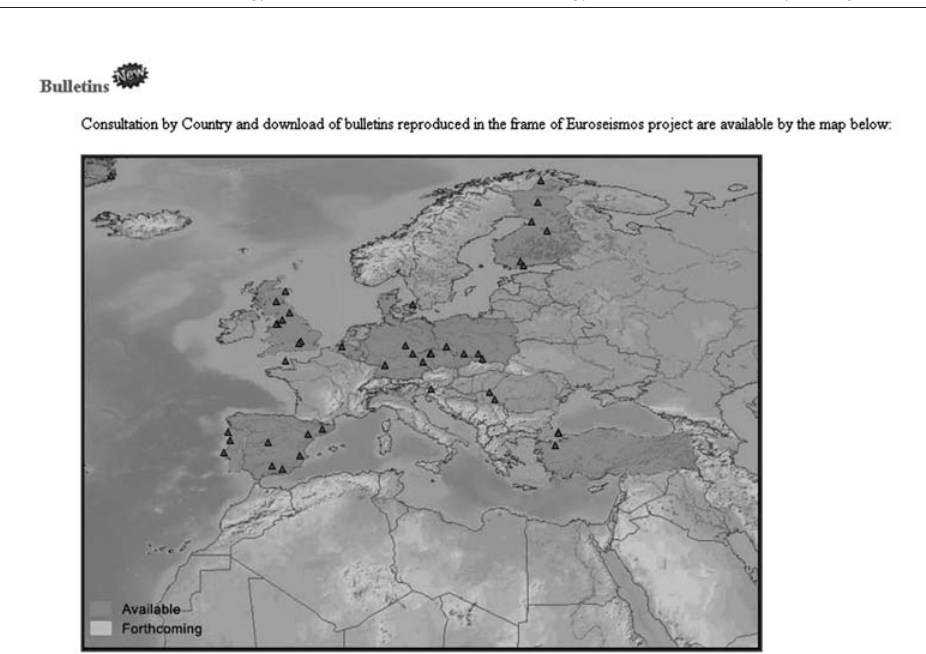
Fig. 16. Euroseismos website: Geographic access by country to the seismic bulletins of the different observa- tories. By clicking on the map it is possible to ace the list of bulletins collected during the project for each coun- try. From this list it is possible to open the PDF file of the integral raster reproduction of each single